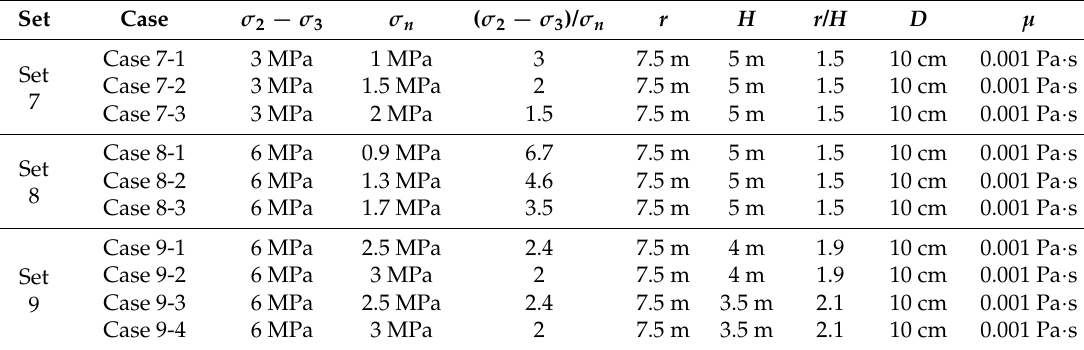
Table 11. Operation parameters designed for the expected PHF field trials in the E26 and E48 orebodies at Northparkes